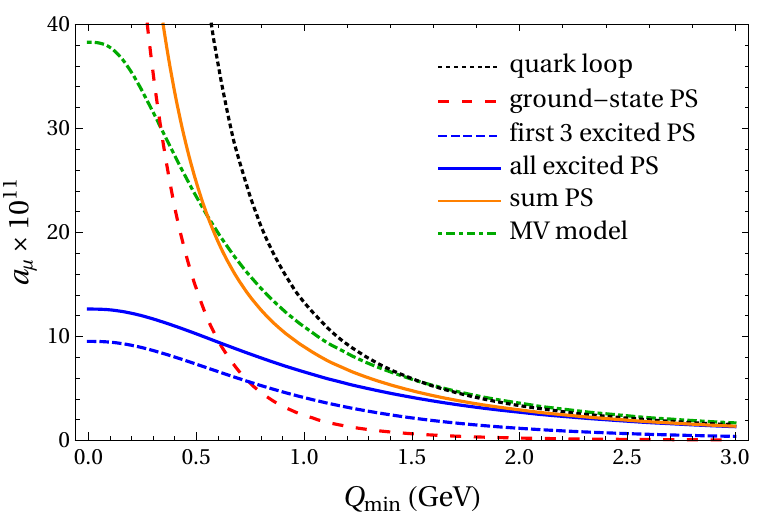
Figure 14. Contribution to a (cid:22) for Q i (cid:21) Q min : the longitudinal part of the massless pQCD quark loop (dotted black), the ground-state pseudoscalars (long-dashed red), their excitations from the large- N c Regge model (blue), the sum of both (orange), and the short-distance implementation from the MV model (dot-dashed green). The blue dot-dashed curve refers the sum of the (cid:12)rst three excited pseudoscalars in each trajectory.